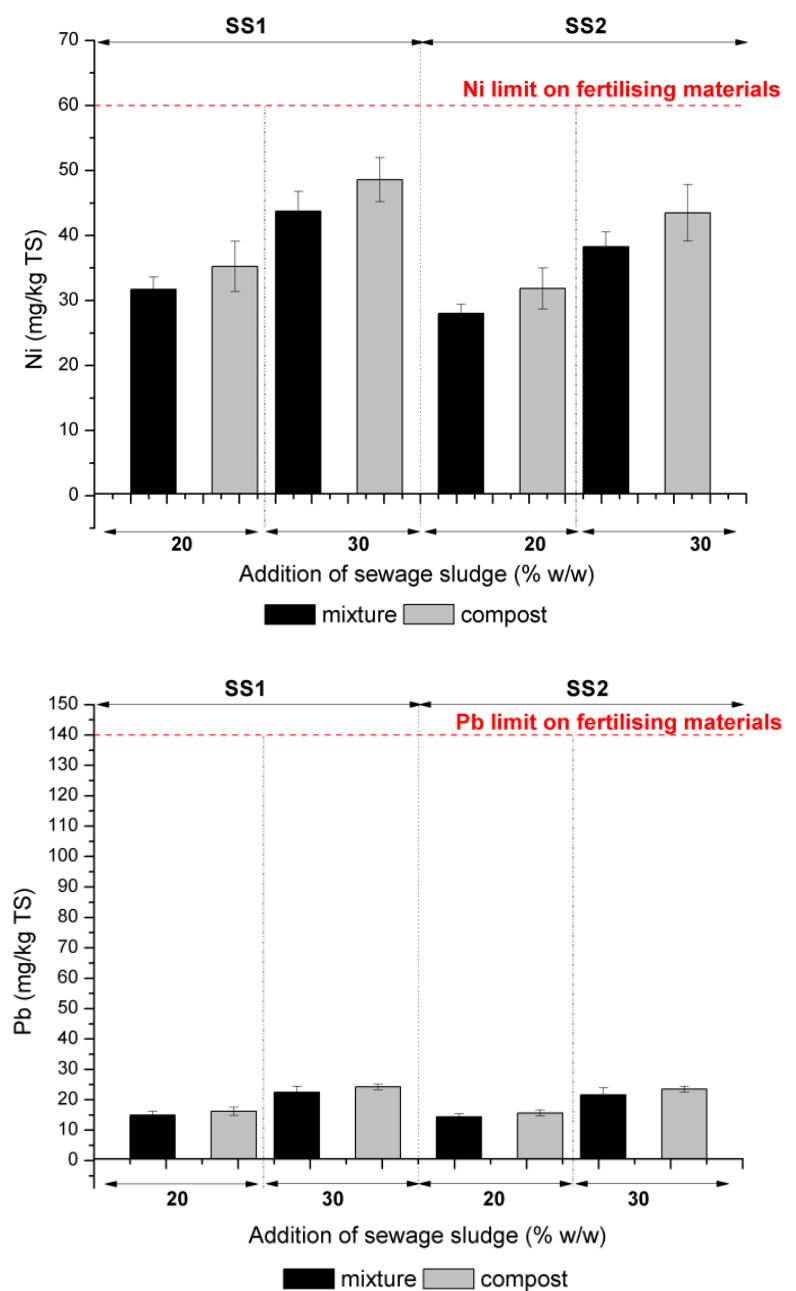
Figure 5. Comparison of total heavy metals content in mixtures and compost with Polish Regulations requirements in red.